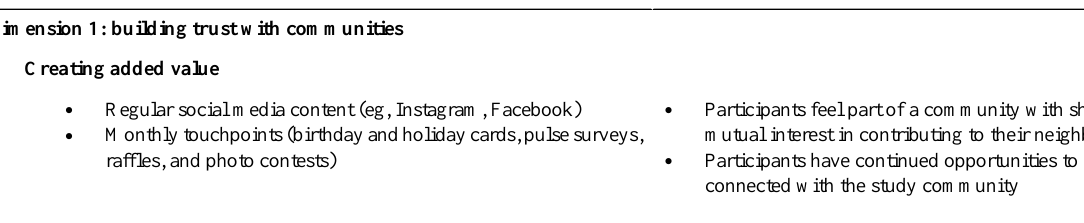
Hypothesized impactMethods and strategies